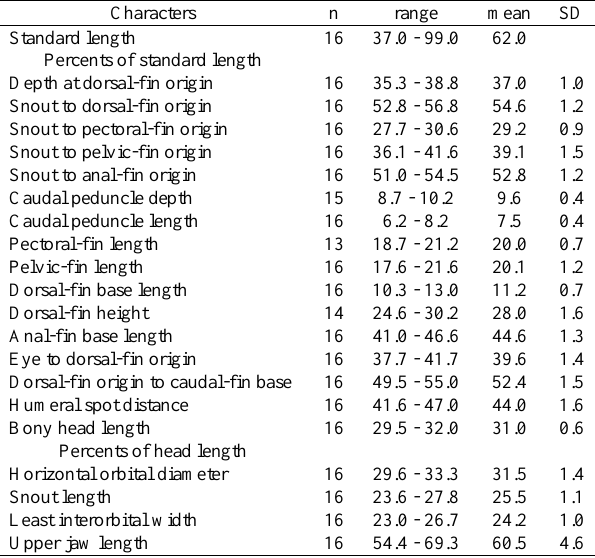
Table 9. Morphometrics of Charax metae . Specimens are from CAS